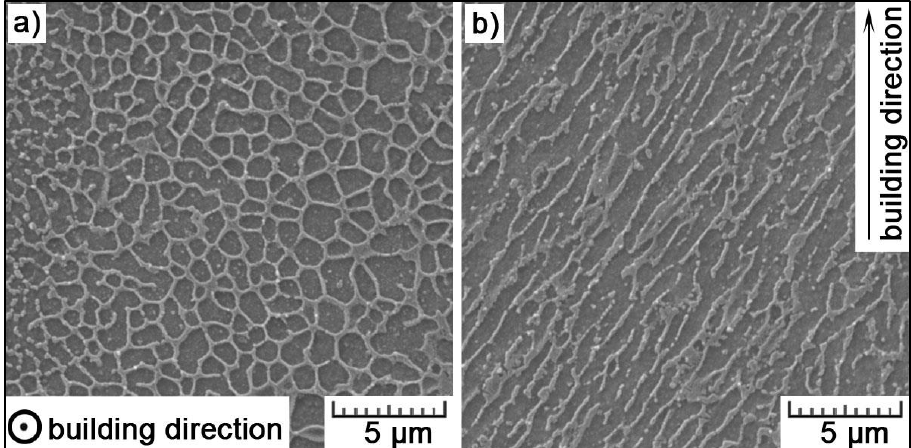
Figure 5. Fine cellular substructure in ( a ) transversal and ( b ) longitudinal section.